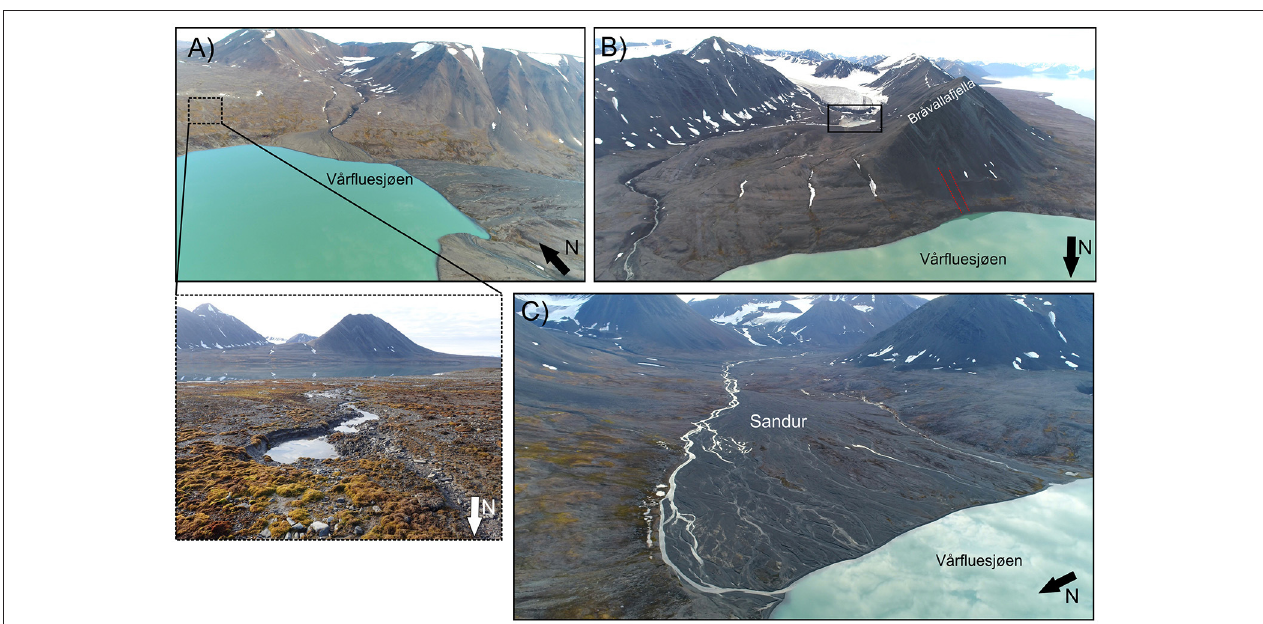
FIGURE 3 | Pictures from the Vårfluesjøen catchment showing (A) the inlet from north with the delta fan. Dotted rectangle indicates the area with slope failure, as shown in the picture below. Smaller pit is ∼ 1–2m wide. (B) Stratusdalen with the terminus of Bybreen. Note the black rectangle showing a smaller lake upstream from Vårfluesjøen. The red dotted line suggests the minor avalanche track down from Bråvallafjella. (C) Main valley in the Vårfluesjøen catchment with the prominent sandur plain ( ∼ 450m wide).